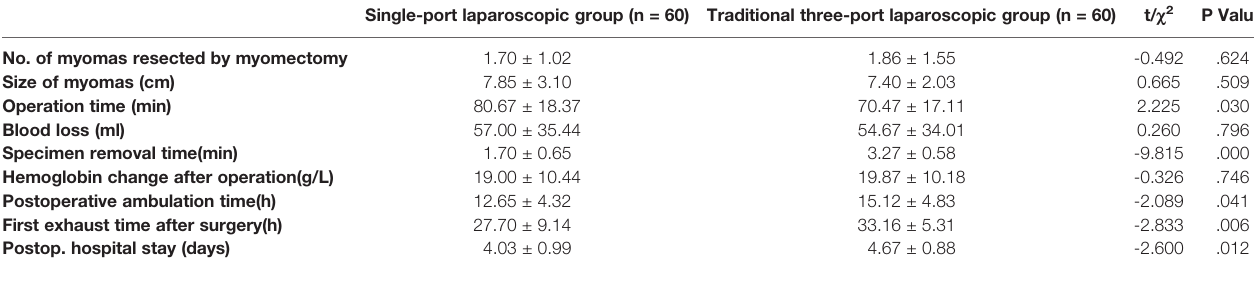
TABLE 2 | Surgical outcomes of the patients in single-port laparoscopic group and traditional three-port laparoscopic group.